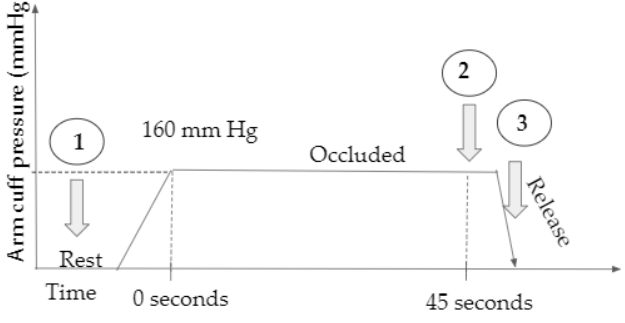
Figure 4. A schematic of the occlusion study including the three time stamps at which NIR images were acquired using the SPOT device (schematic not to scale).